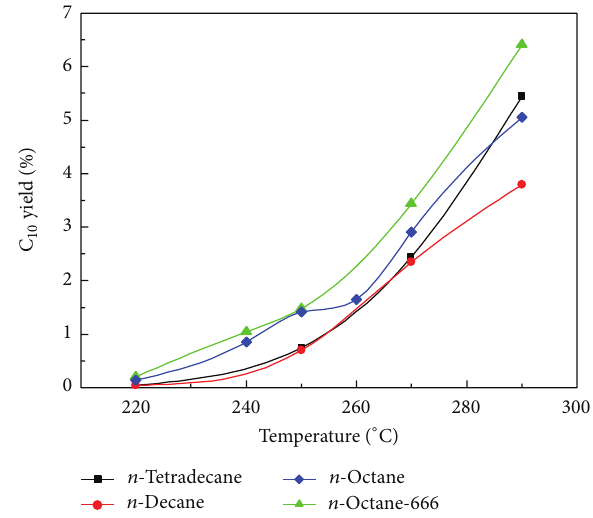
Figure 2: C 10 yield versus temperature in different solvents.